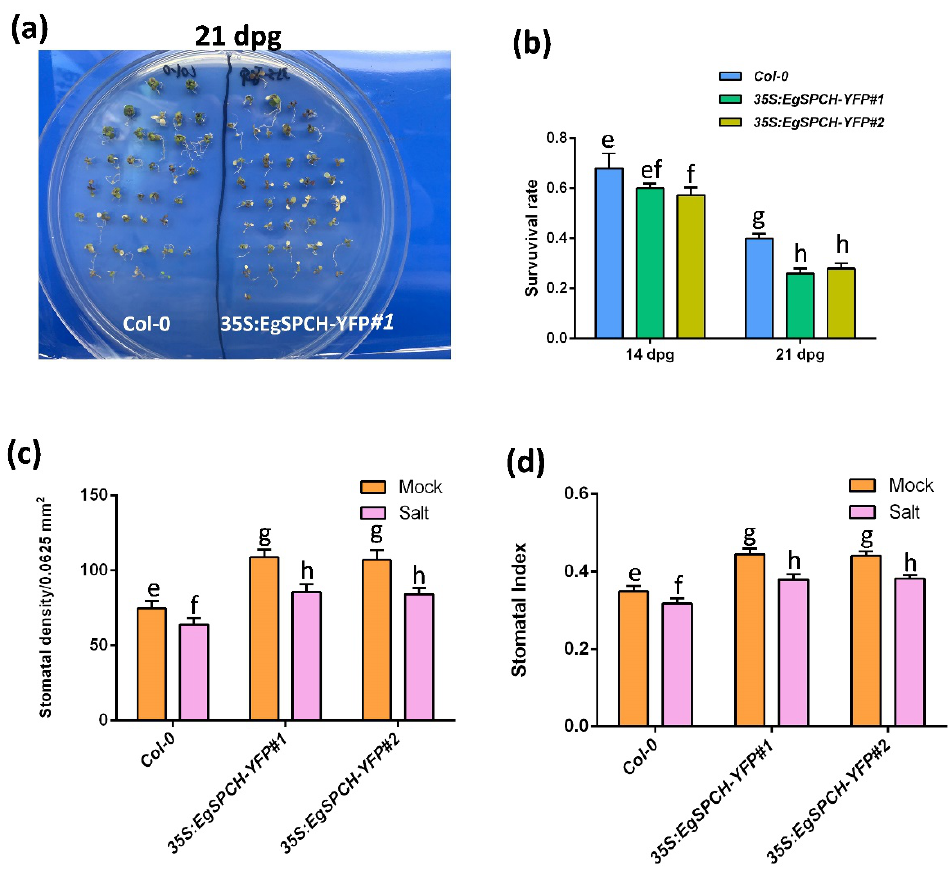
Figure 6. ( a ) Col-0 and 35S-EgSPCH-YFP seeds were germinated and grown on ½ MS plates for 7 days, after which, they were transferred to ½ MS+ 150 mM NaCl plates for 7 and 14 more days (14 and 21 dpg). ( b ) Survival rate of Col-0 and 35S-EgSPCH-YFP seedlings from ( a ) at 14 dpg and 21 dpg. n = 40. ( c ) Stomatal density of abaxial cotyledons from ( a ) at 14 dpg. ( d ) Stomatal index of samples from ( a ) at 14 dpg. Values are mean ± SD; n = 20. One-way ANOVA with post-hoc Tukey HSD; p <